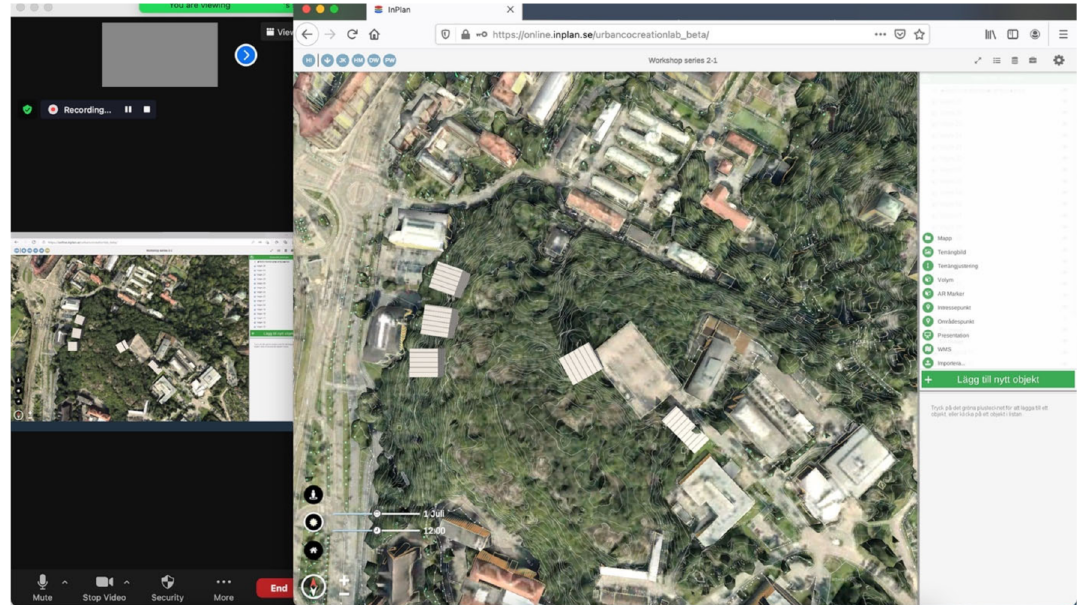
Figure 6. Zoom session with the screen sharing function. The image has been modified to protect personal information. The green buttons on the right indicate (from the top): Folder, Terrain image, Terrain adjustment, Volume, AR marker, Interest point, Area point, Presentation, WMS, Import. The plus button is used for placing a new